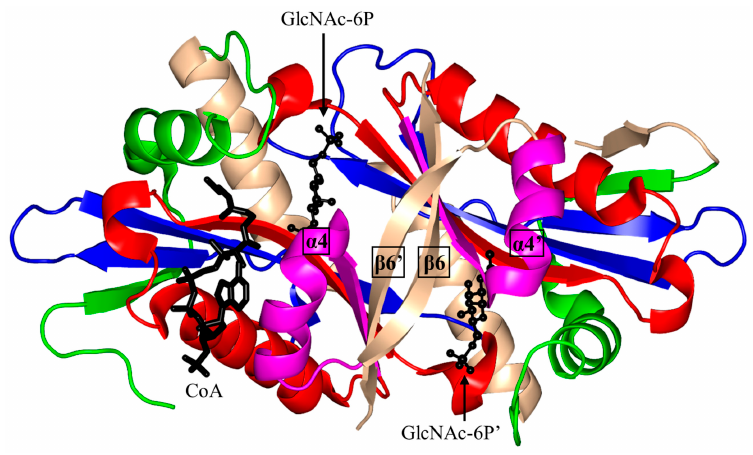
Figure 7. Cartoon representation of the structure of dimeric yeast glucosamine-6-phosphate N - acetyltransferase 1 in complex with CoA and N -acetyl- D -glucosamine-6-phosphate (GlcNAc-6P) (PDB ID: 1I1D [99]). The conserved and non-conserved motifs of the GNAT domain, cofactor and substrates are colored as in Figure